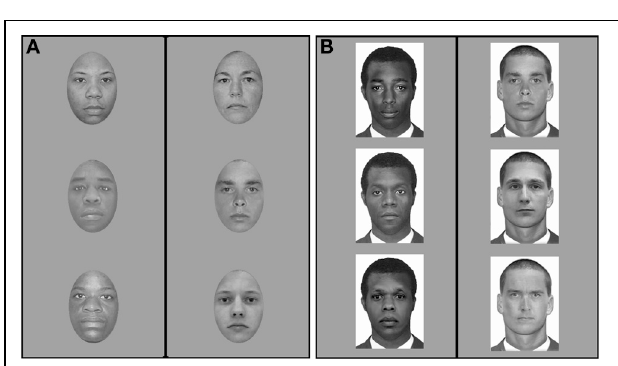
FIGURE 3 | Face images used as primes. (A) Examples of face images used as primes in the ALPS study run in the US prior to the 2008 presidential election—sample black faces are shown in the left column, sample white faces are shown in the right column. (B) Examples of face images used as primes in the ALPS studies run in Canada prior to the 2008 presidential election and in the US and Canada following the 2008 presidential election—sample black faces are shown in the left column, sample white faces are shown in the right column.